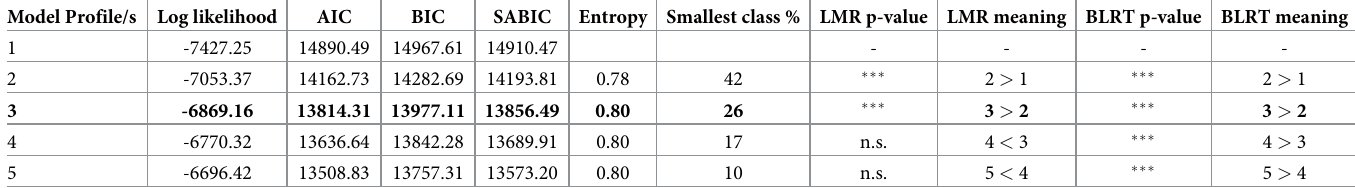
Table 3. LPA model fit summary. Model Profile/s Log